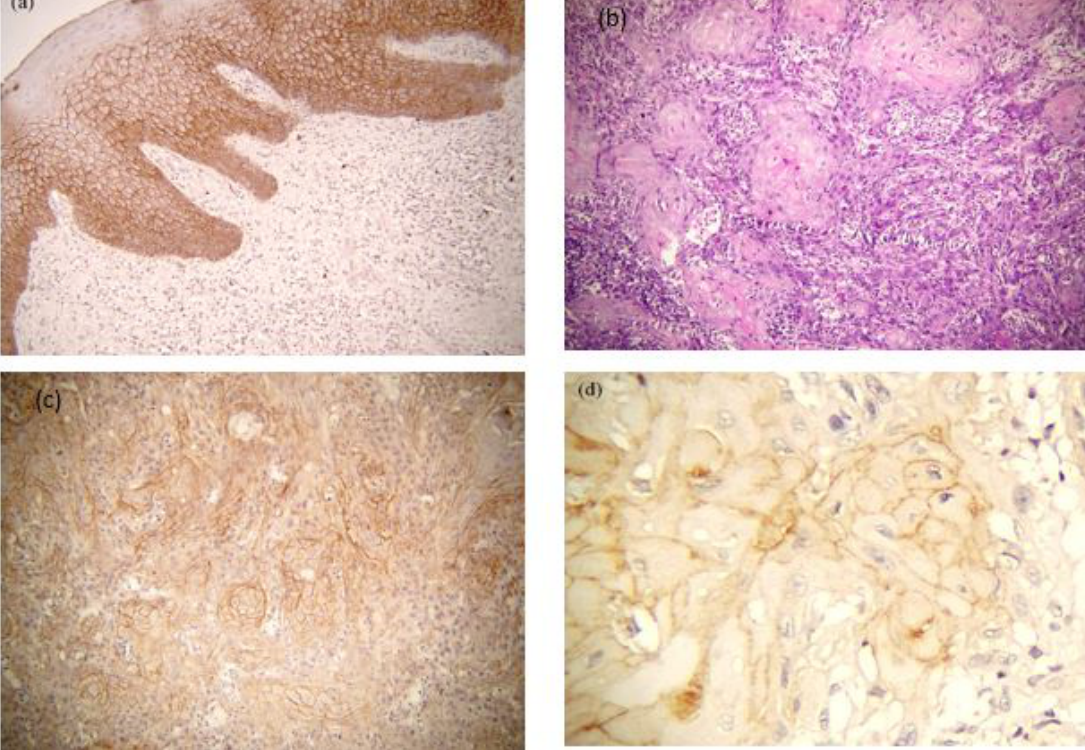
Table 2. Expression of E-Cadherin and N-cadherin in OSCC and Normal epithelial cells Group